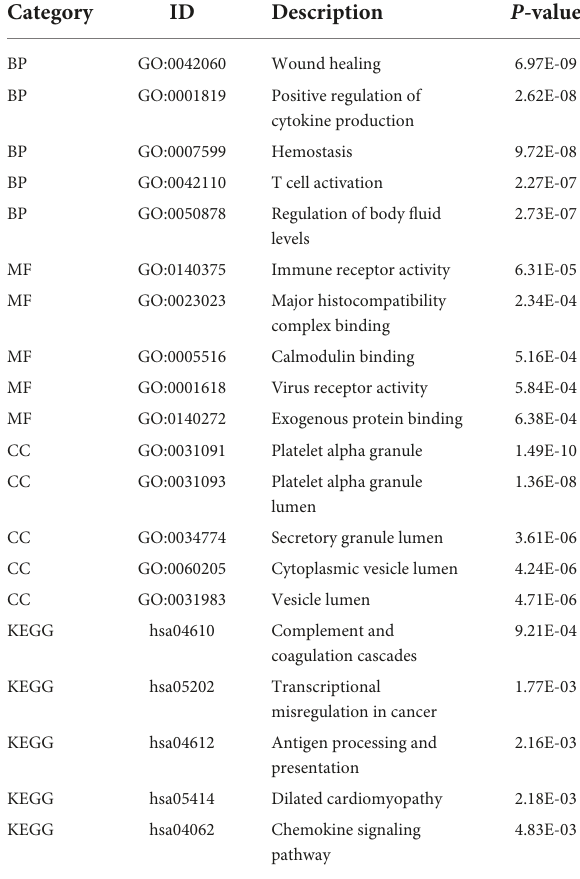
TABLE 3 Top five terms in GO and KEGG enrichment